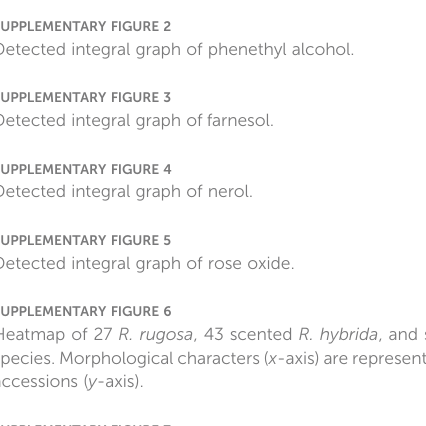
SUPPLEMENTARY FIGURE 2 Detected integral graph of phenethyl alcohol. SUPPLEMENTARY FIGURE 3 Detected integral graph of farnesol. SUPPLEMENTARY FIGURE 4 Detected integral graph of nerol. SUPPLEMENTARY FIGURE 5 Detected integral graph of rose oxide. SUPPLEMENTARY FIGURE 6 Heatmap of 27 R. rugosa , 43 scented R. hybrida , and seven aromatic R. species. Morphological characters ( x -axis) are represented for the 77 Rosa accessions ( y -axis).